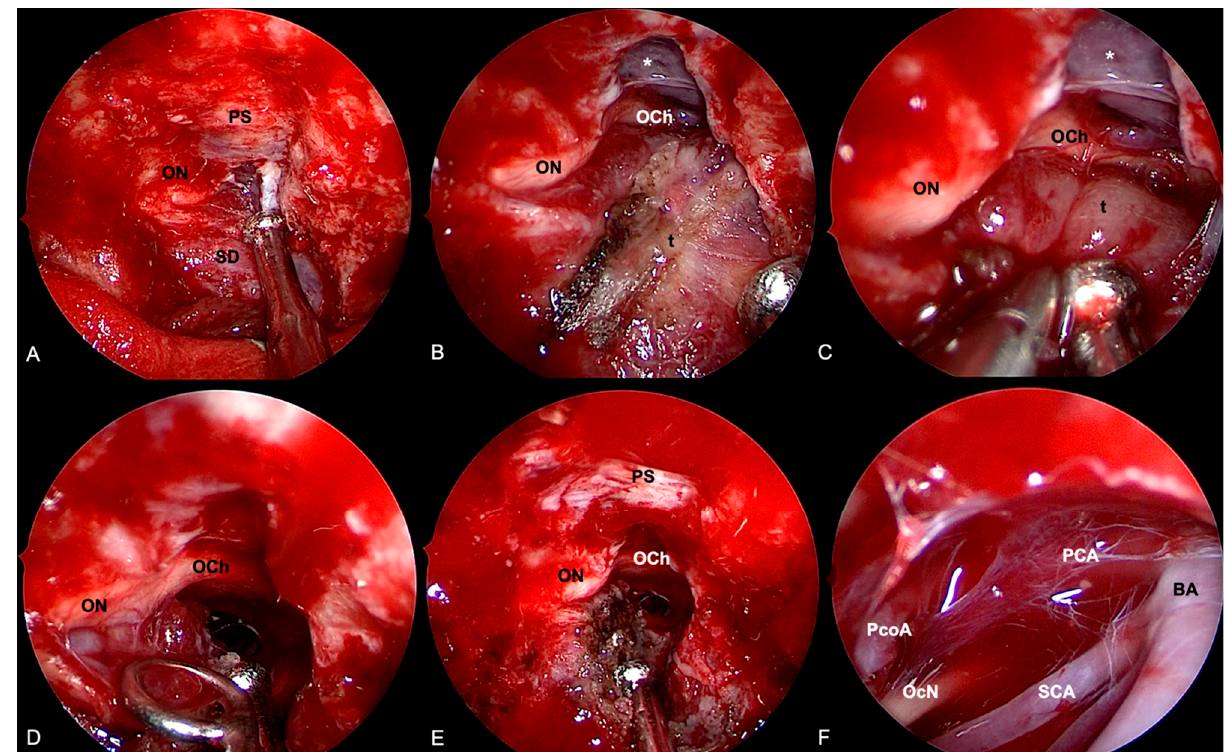
Figure 8. Extended endoscopic endonasal approach for removal of right cavernous sinus meningioma. ( A ) Bone removal encompasses the opening of the mesial aspect of the right optic foramen. ( B ) Sellar dura and planum sphenoidale are exposed. The tumor is coagulated, and the removal proceeds by means of intra and extracapsular dissection. A cleavage plane is found between the lesion and the optic chiasm ( C ) and nerve ( D ). ( E ) After optic nerve and chiasm decompression, the tumor is not followed inside the cavernous sinus. ( F ) Exploration of the interpeduncular cistern through a subchiasmatic window: Basilar artery (BA) and right posterior cerebral artery (PCA), posterior communicating artery (PcoA), and oculomotor nerve (OcN) are identified. Tumor (t); sellar dura (SD); planum sphenoidale (PS); optic nerve (ON); optic chiasm (OCh); oculomotor nerve (OcN); posterior communicating artery (PcoA); posterior cerebral artery (PCA); basilar artery (BA); superior cerebellar artery (SCA); lamina terminalis cistern (*).